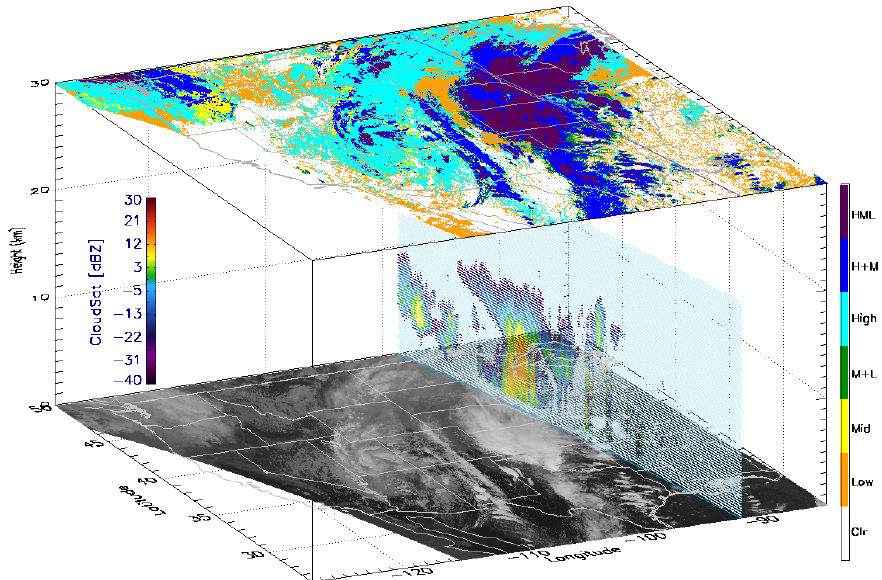
Figure 9. Sample of the improved NOAA Enterprise Cloud Cover Layers (CCL) Product from S- NPP VIIRS over the central U.S. (1954 UTC on 7 October 2018) together with a CloudSat overpass cross-section showing the detailed cloud top, cloud base, and vertical layer information. The newly enhanced CCL includes vertically extended layer categories such as High+Low, High+Mid, Mid+Low, and High+Mid+Low.